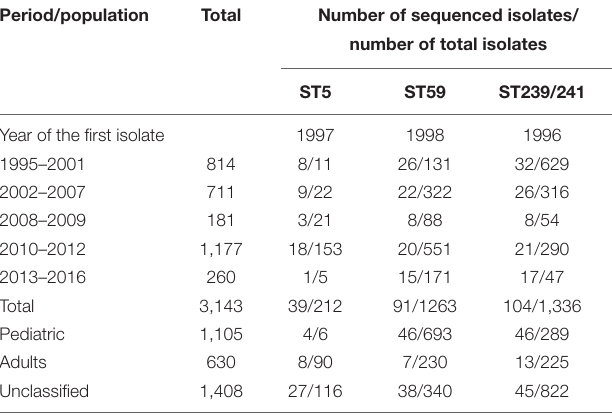
TABLE 2 | Distribution of clinical methicillin-resistant Staphylococcus aureus isolate total numbers, numbers of ST5, ST59, andST239/241 isolates in different years of collection, and numbers of isolates selected for whole-genome sequencing analysis in the Chang Gung Memorial Hospital-based collection.